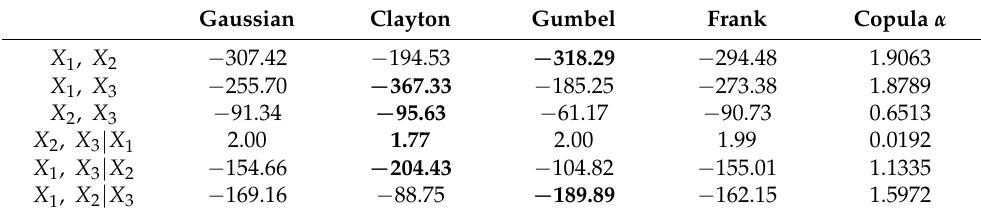
Table 7. Values of parameter estimation and AIC method ( N = 500). Gaussian Clayton